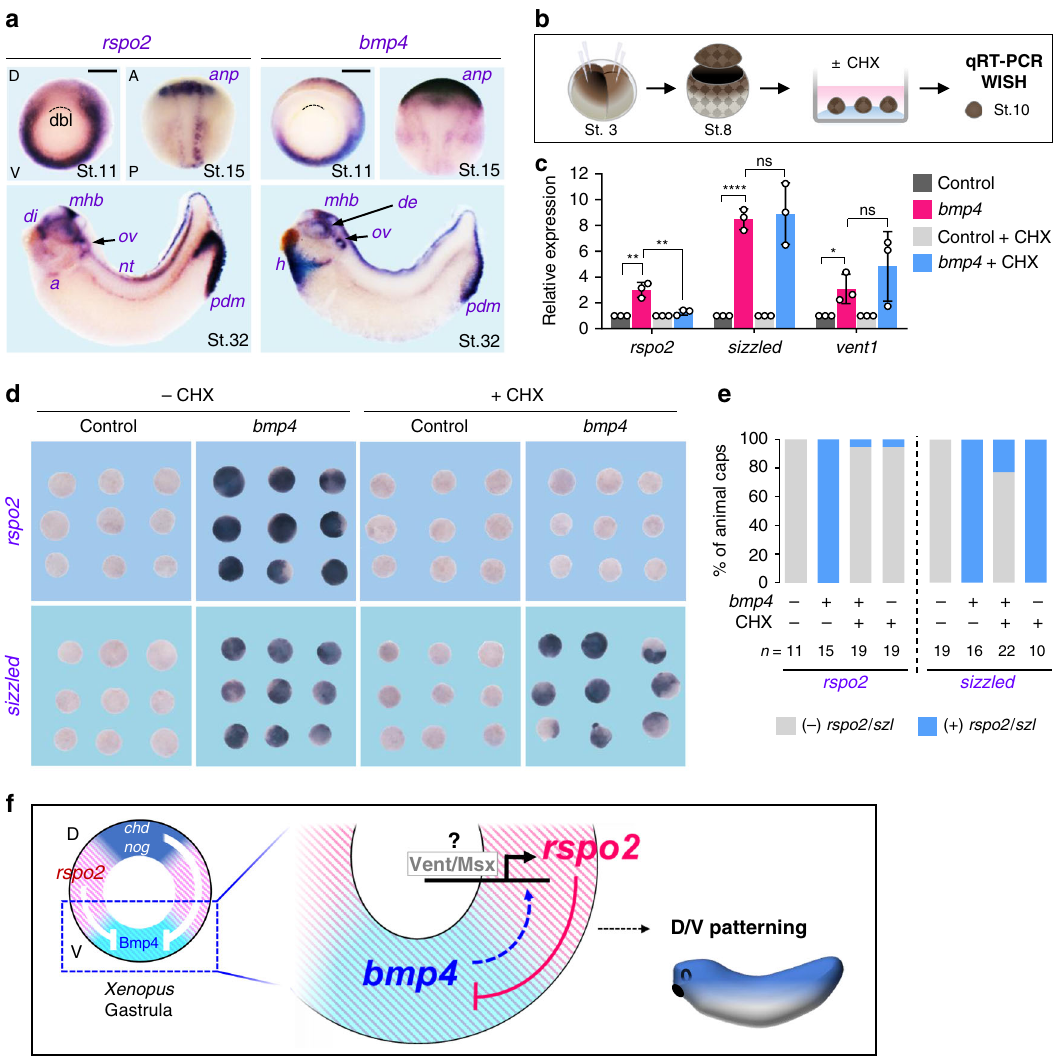
Fig. 3 Rspo2 is a negative feedback inhibitor in the BMP4 synexpression group. a In situ hybridization of rspo2 and bmp4 in Xenopus laevis at gastrula (St. 11, dorsal to the top, vegetal view), neurula (St. 15, anterior to the top, dorsal view), and tadpole (St. 32, anterior to the left, lateral view). Dashed lines, dorsal blastopore lip (dbl); anp, anterior neural plate; di, diencephalon; mhb, mid-hindbrain boundary; ov, otic vesicle; a, atria; nt, neural tube; de, dorsal eye; h, heart; pdm, proctodeum. Scale bar, 0.5 mm. b Microinjection and experimental scheme for c – e . 2 or 4 cell stage Xenopus laevis embryos were animally injected with control ( ppl ) or bmp4 mRNA. The animal cap (AC) explants were dissected from injected embryos at stage 8, and either treated or untreated with cycloheximide (CHX) until control embryos reached stage 10 for qRT-PCR ( c ) or in situ hybridization ( d , e ). c qRT-PCR of rspo2 , sizzled , and vent1 expression in the AC explants injected and treated as indicated. Data are pooled from three independent experiments with similar results and displayed as means ± SD. ns, not signi fi cant, * P < 0.05, ** P < 0.01, **** P < 0.0001 from two-tailed unpaired t -test. d In situ hybridization of rspo2 and sizzled in the